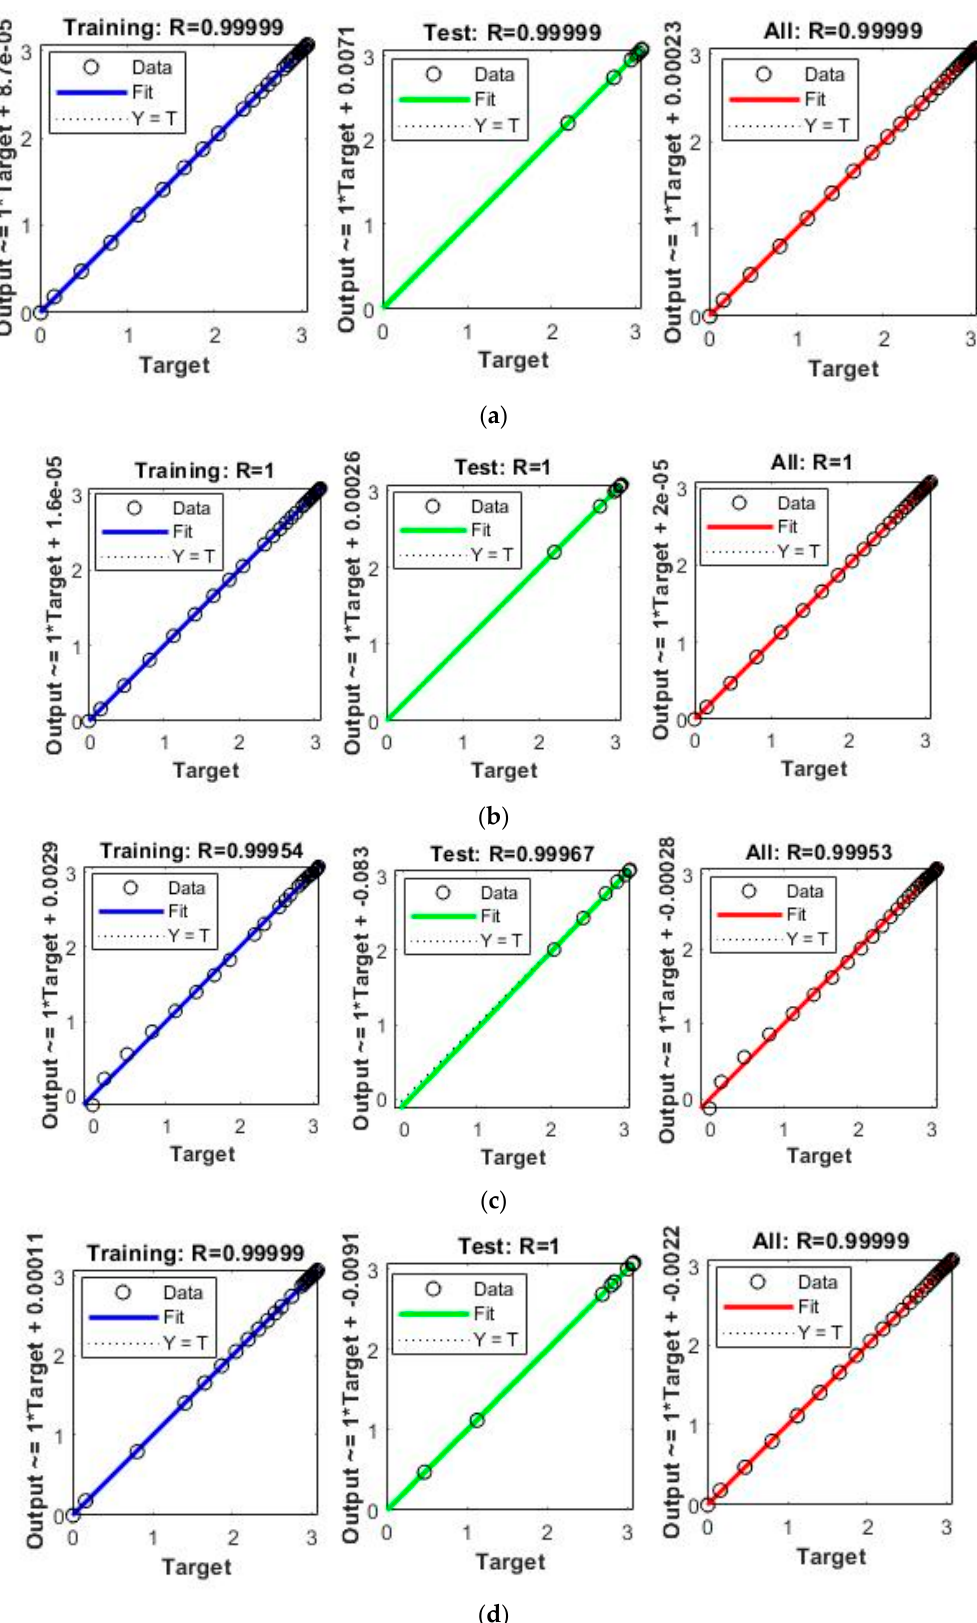
Figure 12. Regression analysis for training, validation, and testing by BRM ‐ NNs of the Dahl ‐ based hysteresis model of the piezoelectric actuator. ( a ) BRM ‐ NNs Case 1. ( b ) BRM ‐ NNs Case 2. ( c ) BRM ‐ NNs Case 3. ( d ) BRM ‐ NNs Case 4.